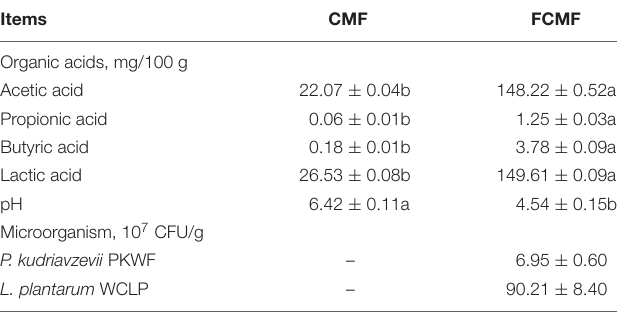
TABLE 4 | In vitro crude protein (CP) and amino acid (AA) digestibility (%) of CMF and FCMF.